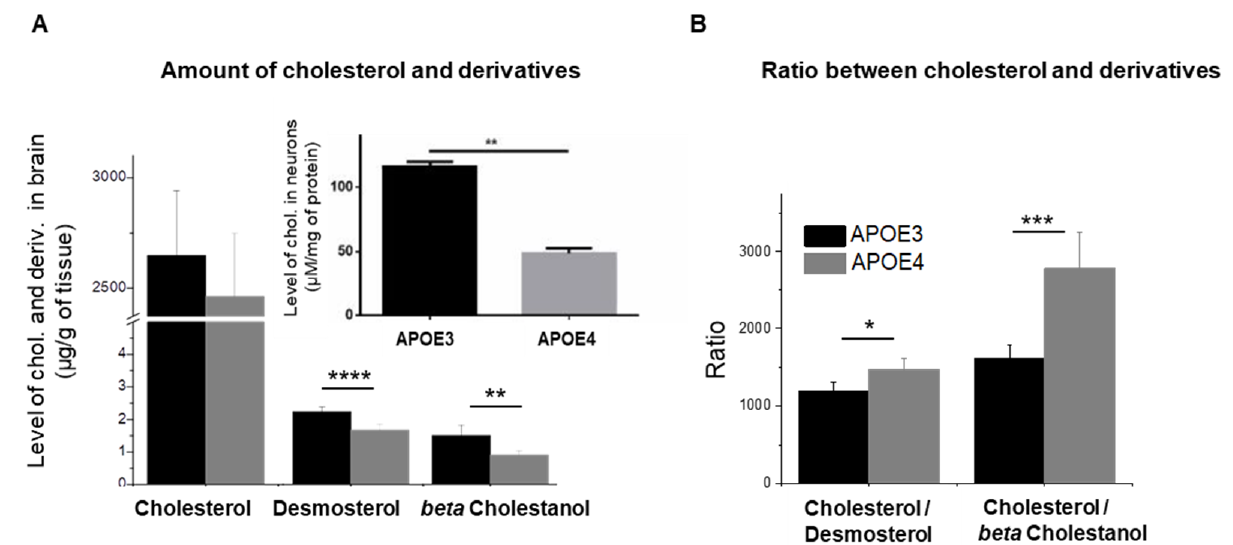
Figure 1. Level of cholesterol and other sterols in the brain of APOE3 and APOE4-KI mice: ( A ) amount of different sterols detected; the insert shows the level of intracellular cholesterol in primary neurons. ( B ) Ratio between cholesterol and derivatives; the results are means of seven or eight sam- ples/APOE genotype. Statistics: Multiple paired t -test *: p < 0.05, **: p < 0.01, and ***: p < 0.001.